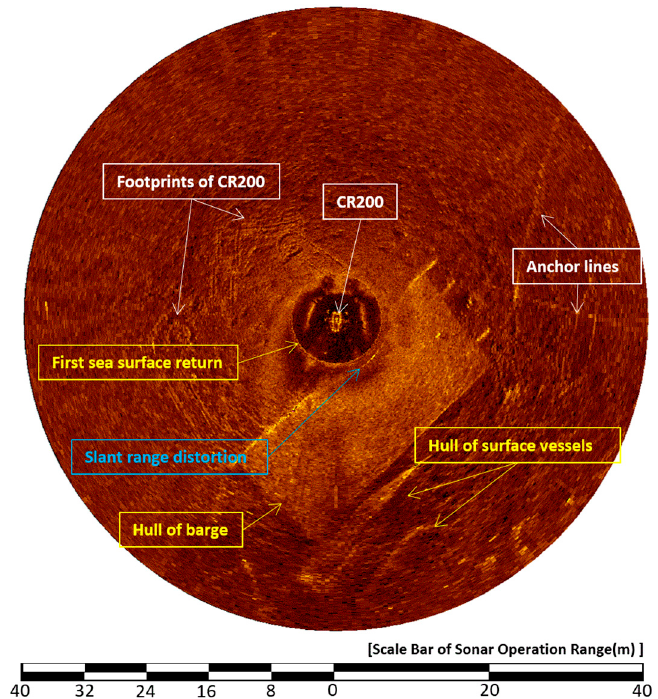
Figure 20. Horizontal sonar image under the support barge.